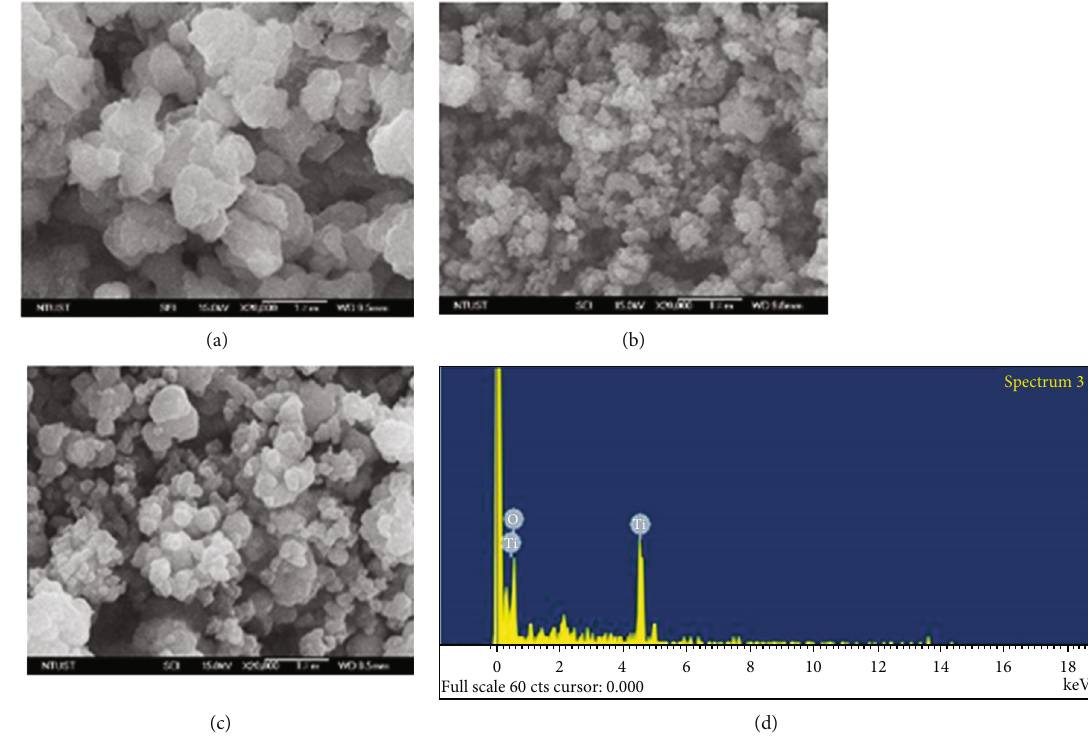
Figure 7: SEM images of TiO